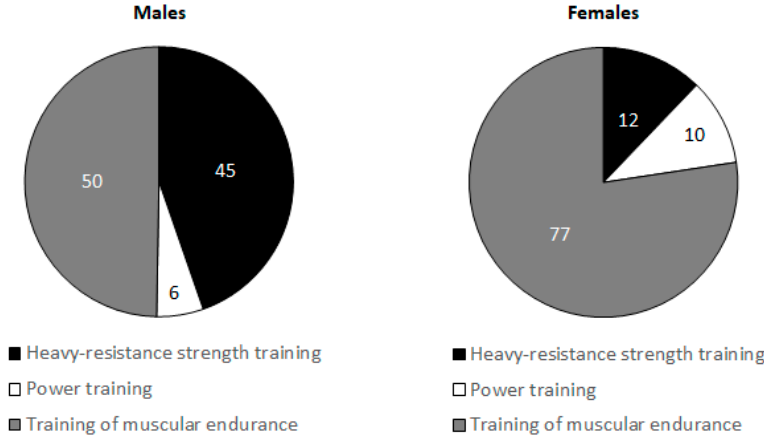
Figure 2. The distribution of the different strength training types across the entire season in young male and female judo athletes (in %).